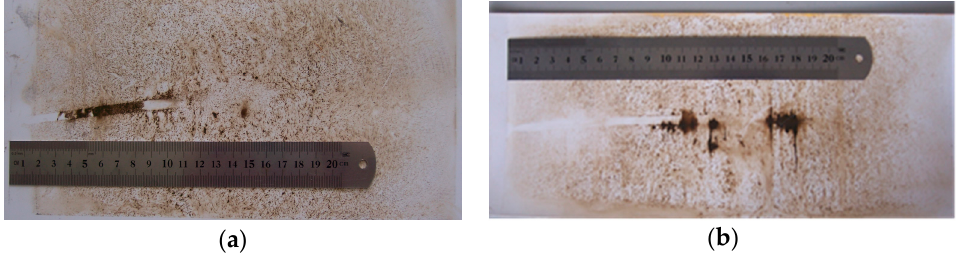
Metals 2017 , 7 , 483